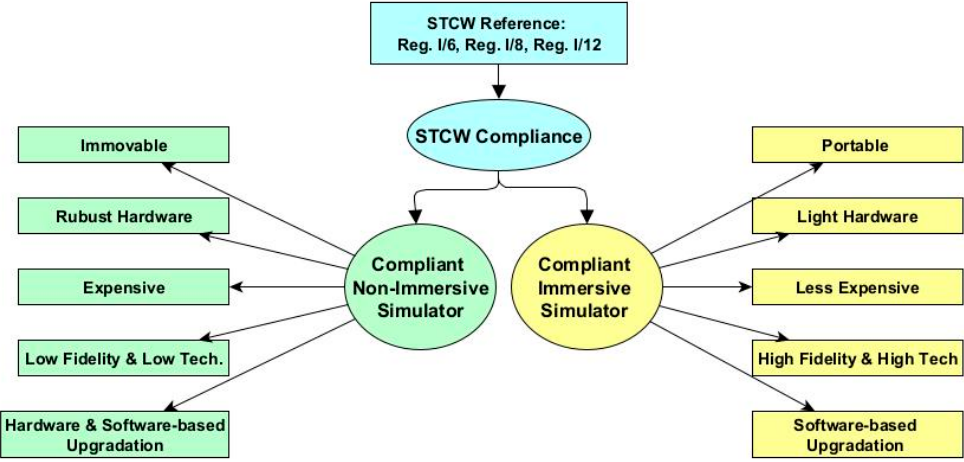
Figure 5. Comparison of STCW Complaint Immersive and Non-Immersive Simulators Using in Maritime Education and Training.